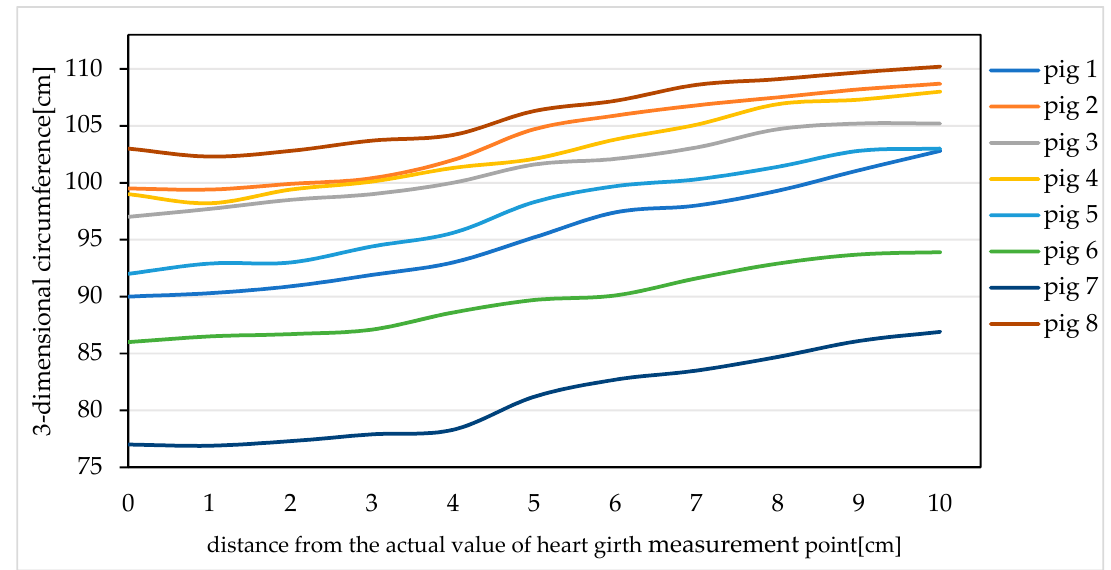
Figure 12. Curves representing the 3-dimensional circumferences of individual pigs starting from the actual heart girth measurement point and moving towards the hips (the origin of the horizontal coordinate corresponds to the actual heart girth measurement point, and the value on the vertical axis corresponding to the origin is the true heart girth value of the pig).